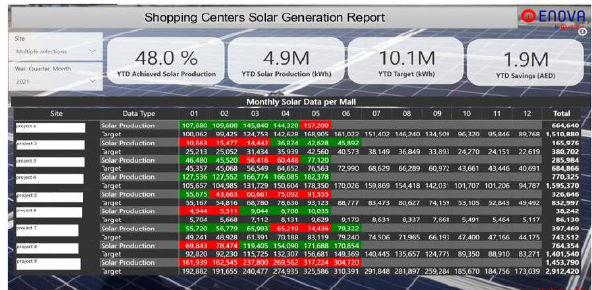
Figure 6: Solar Energy generation Dashboard for shopping